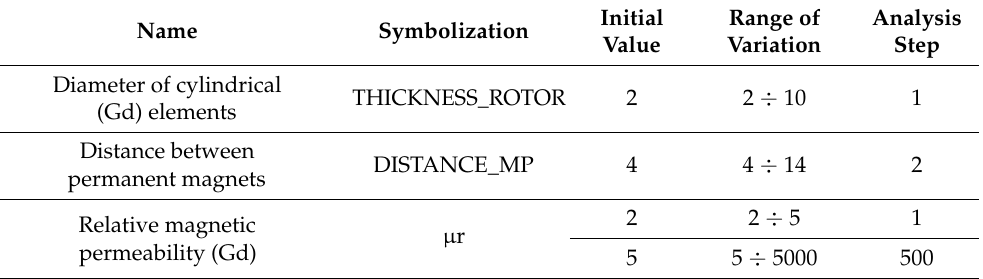
Table 2. Changed physical parameters in modeling.